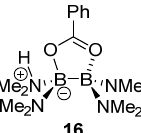
Figure 3. Mechanistic insights into the carboxylic acid activation with diboron catalyst 9.